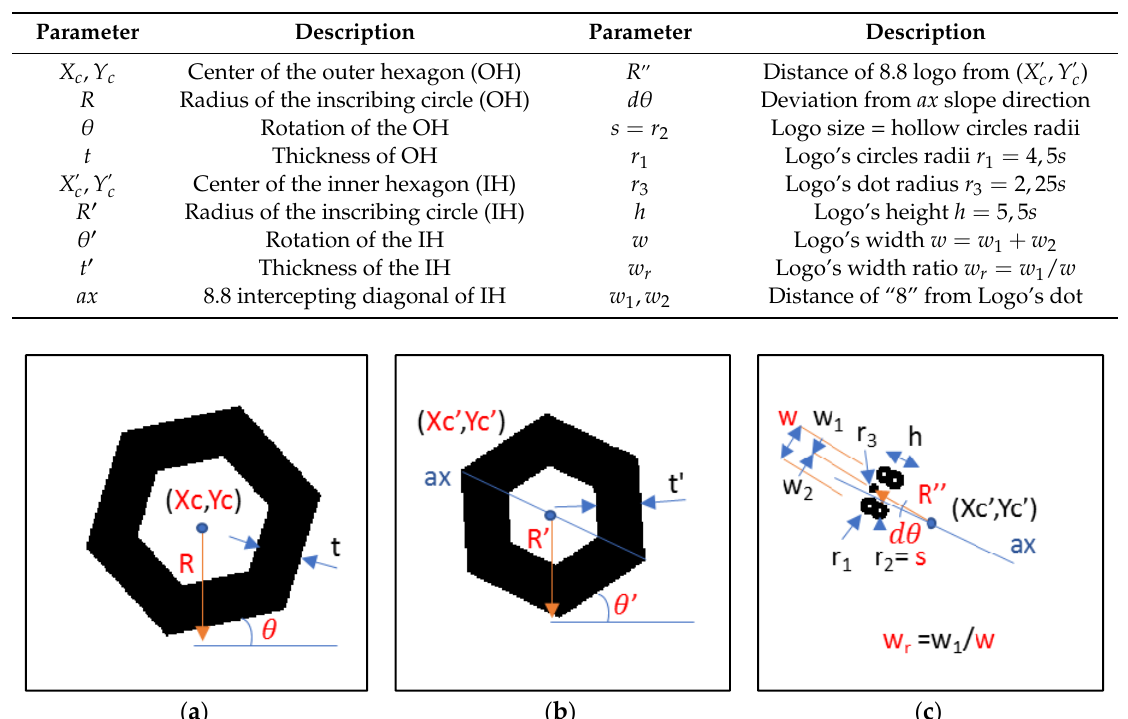
Figure 7. Binary templates after Genetic Algorithm (GA) optimization on the first frame (Figure 3a) with characteristic parameters highlighted in red (overall, 13 independent parameters, as reported in Table 1): ( a ) Outer hexagon template; ( b ) Inner hexagon template; ( c ) 8.8 logo template. N.B., The pictures “quantization” effect is determined by the 191 × 191 px grid of the search image, which dictates the final template resolution. Table 1. Characteristic variables of the three parametric templates. The 13 independent variables are highlighted in red, (cid:1872) and (cid:1872)’ parameters are constants, while the other parameters are derived. Parameter Description Parameter Description